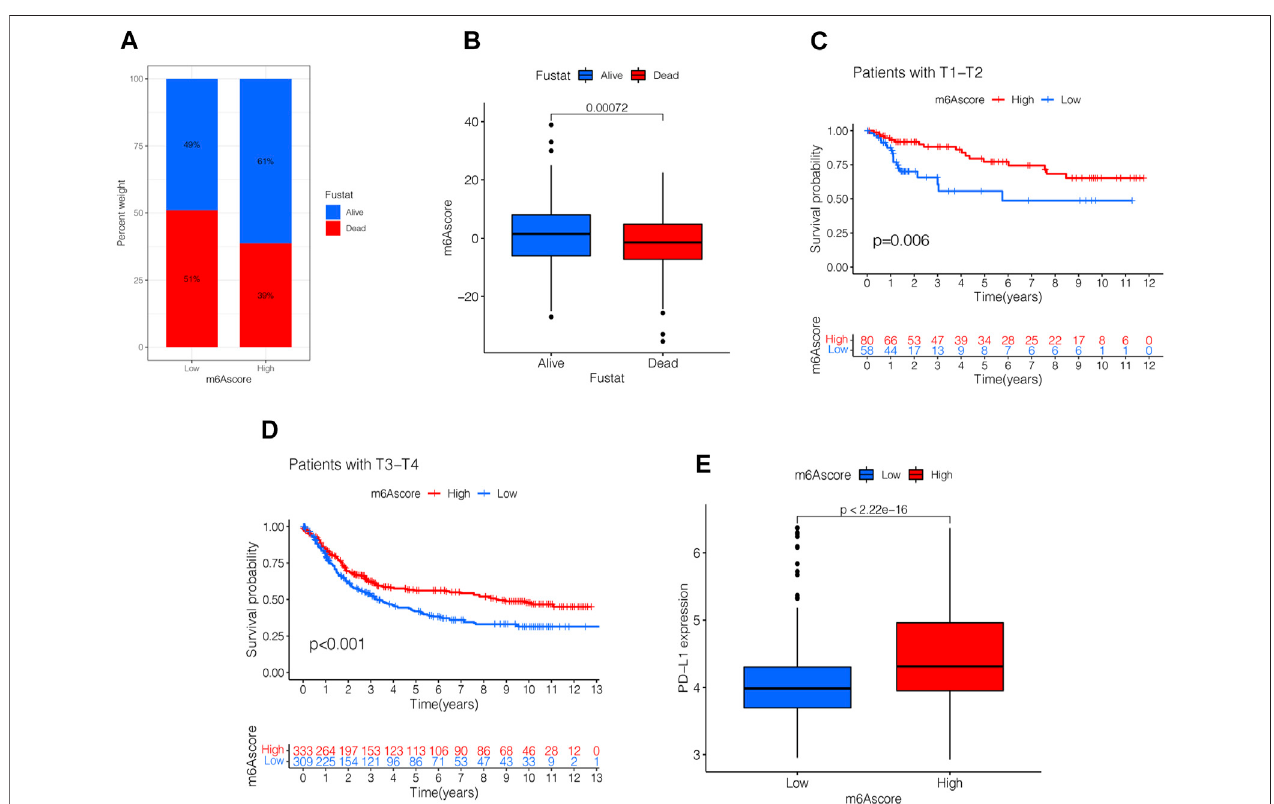
FIGURE 7 | Validation and application of the m6A score in clinical evaluation. (A) Proportion of survival and death in high- and low-m6A score groups. (B) Comparison ofthem6A scorebetweensurvivaland deadpatients ( p < 0.001, Wilcoxon test). (C) Strati fi ed analysisofthem6Ascorefor STADpatientsbyT1-T2 ( p = 0.006, Log-rank test). (D) Strati fi ed analysis of m6A score for STAD patients by T3-T4 ( p < 0.001, Log-rank test). (E) Strati fi ed analysis of m6A score for STAD patients by PD-L1 ( p < 0.0001, Wilcoxon test).